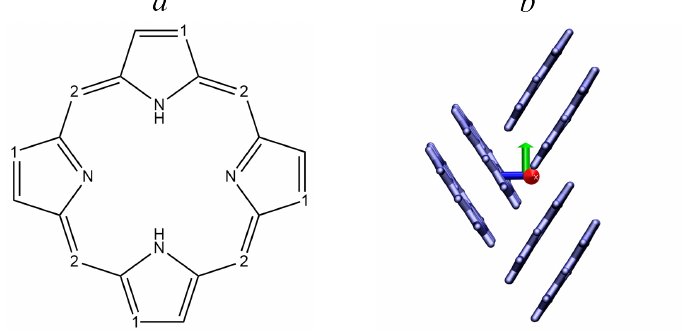
Figure 1. ( a ) Porphine molecule with two possible positions of the substituents (marked as 1 and 2). ( b ) Fragment of porphine crystal packaging with axis